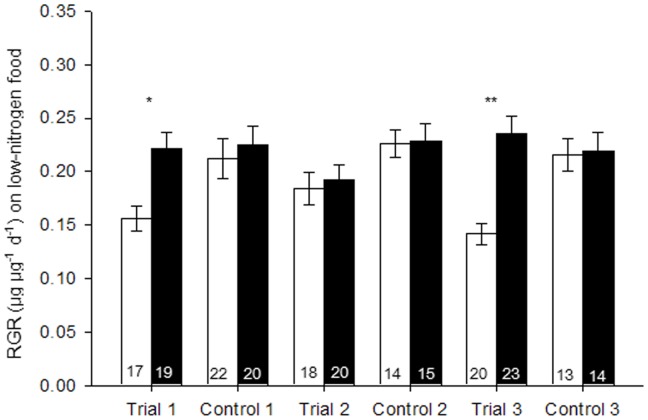
Mean relative growth rate (RGR) of B. tabaci females reared on standard diet (control) or low-nitrogen diet.Black bars and white bars indicate infected and noninfected females, respectively. Replicate numbers are noted within the columns. Values are means±SE. The experiment was performed three times (trial 1–3). For each paired comparison (± infection), asterisks indicate a significant difference (*, p<0.05; **, p<0.01) based on a t-test.